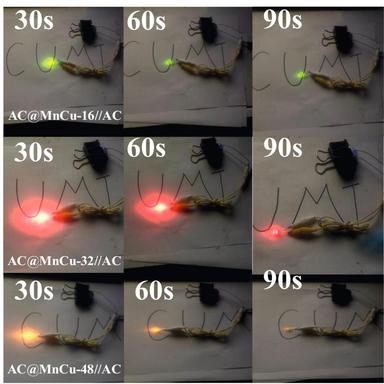
Light-emitting diodes lit by the assembled asymmetric supercapacitors.